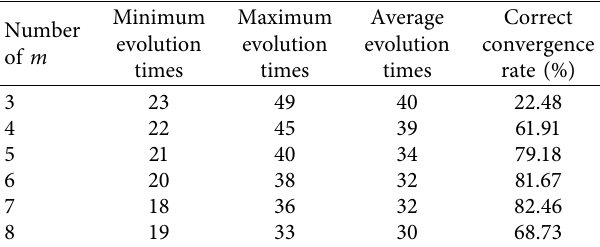
Table 2: Influence of the number of individuals in a subgroup on system performance.